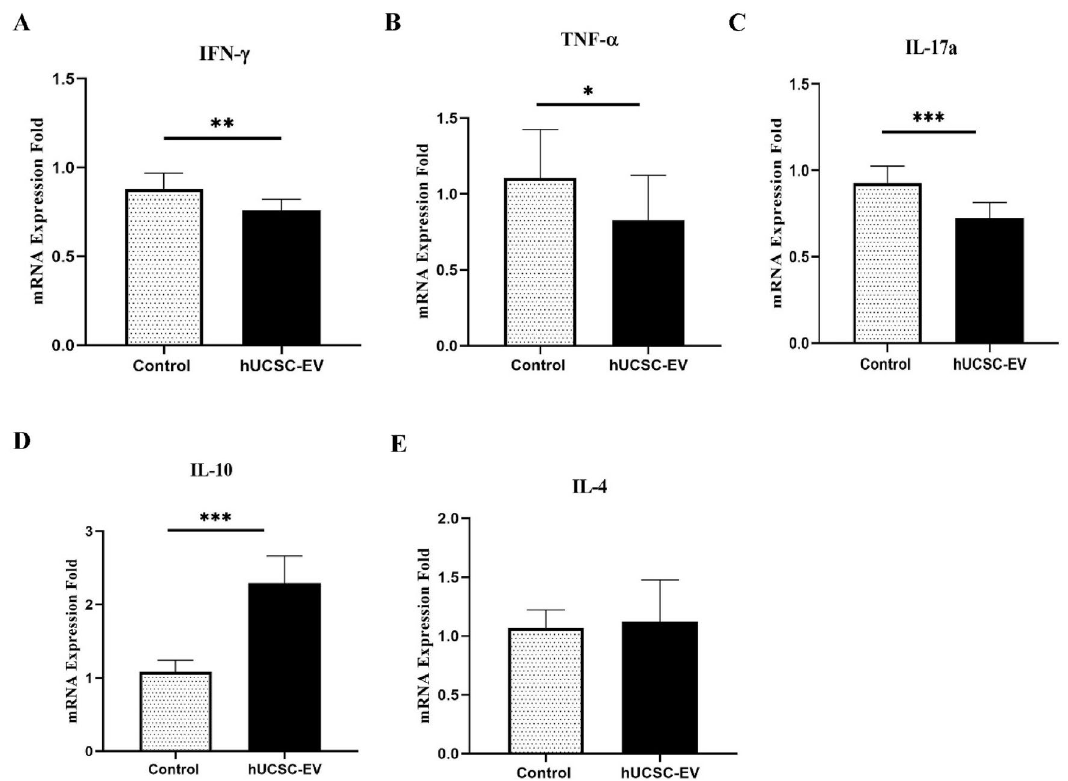
Figure 4. Differential expression of the pro-/anti-inflammatory cytokine genes in the CNS of experimental groups. Quantitative RT-PCR data demonstrated the downregulation of pro-inflammatory cytokines [IFN-γ ( A ), TNF-α ( B ), and IL-17a ( C )] and upregulation of IL-10 ( D ) as anti-inflammatory cytokine in hUCSC- EVs-treated mice compared to EAE control mice. Data are shown as mean ± SD. ***p < 0.001, **p < 0.01, and *p < 0.05. EAE experimental autoimmune encephalomyelitis, hUCSC-EV human umbilical cord mesenchymal stem cell-extracellular vesicle, IFN interferon, IL interleukin, SD standard deviation, TNF tumor necrosis